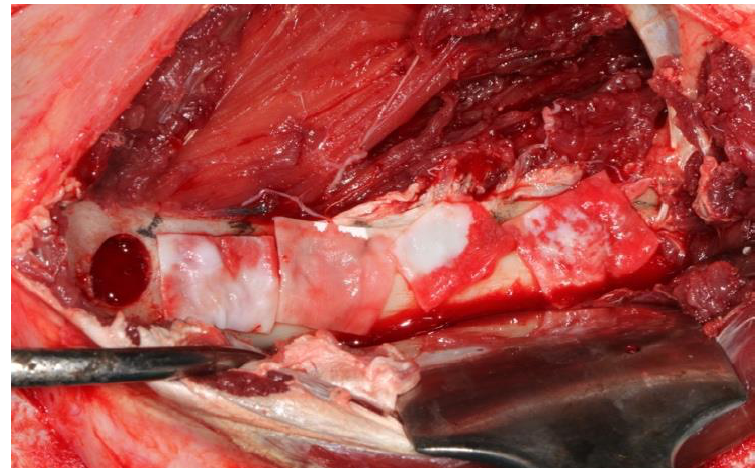
Figure 3. View of surgically created defects in control defects. First defect was left empty. Surfaces of the second and third defects were covered with collagen membrane after they were filled with autogenous bone particles (group G+CM). Surfaces of the fourth and fifth defects were only covered with collagen membrane as they were left unfilled (group CM).